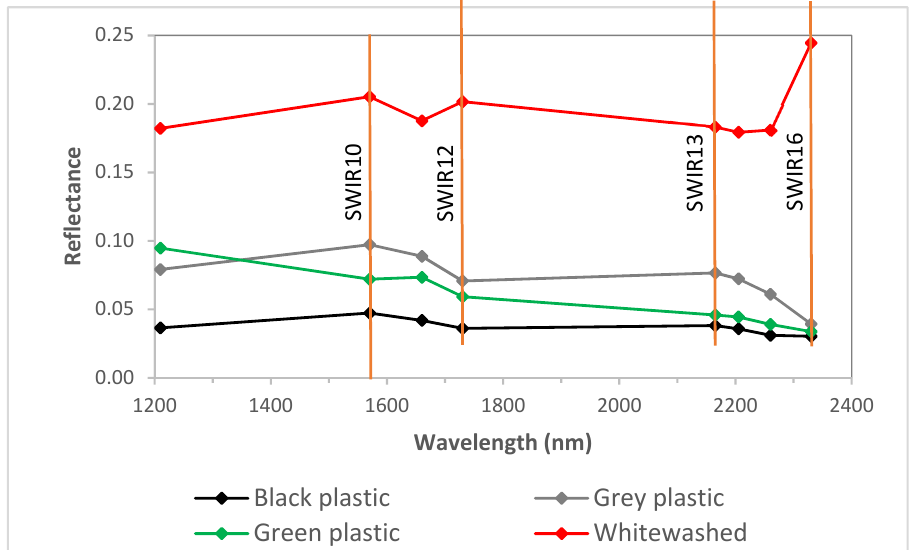
Figure 7. Reflectance values of the SWIR bands of the WV3 image for four PCGs with different colors. The four orange vertical lines represent the central wavelengths of SWIR10, SWIR12, SWIR13 and SWIR16.